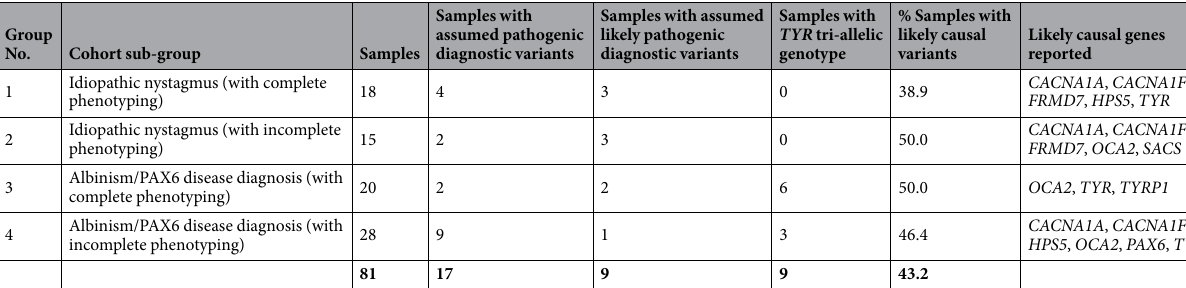
Table 2. Summary table outlining the number of samples harbouring likely causal variants. A diagnostic rate is calculated and the likely causal genes are listed for each phenotype